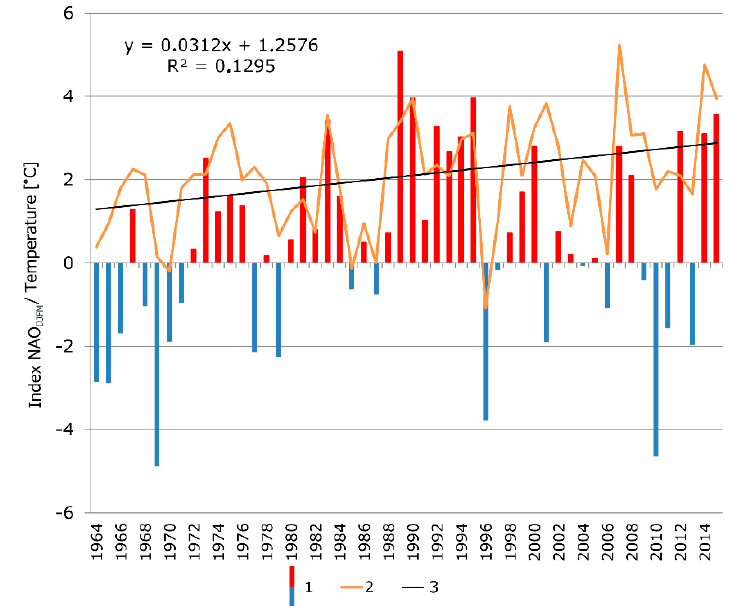
Figure 2. Changes in average air temperature in the winter half-year (XI–IV) in the hydrological years 1964–2015 at the Katowice weather station and values of the winter NAO DJFM index (D—December, J—January, F—February, M—March): 1—NAO DJFM index, 2—average air temperature, 3—average air temperature trend.